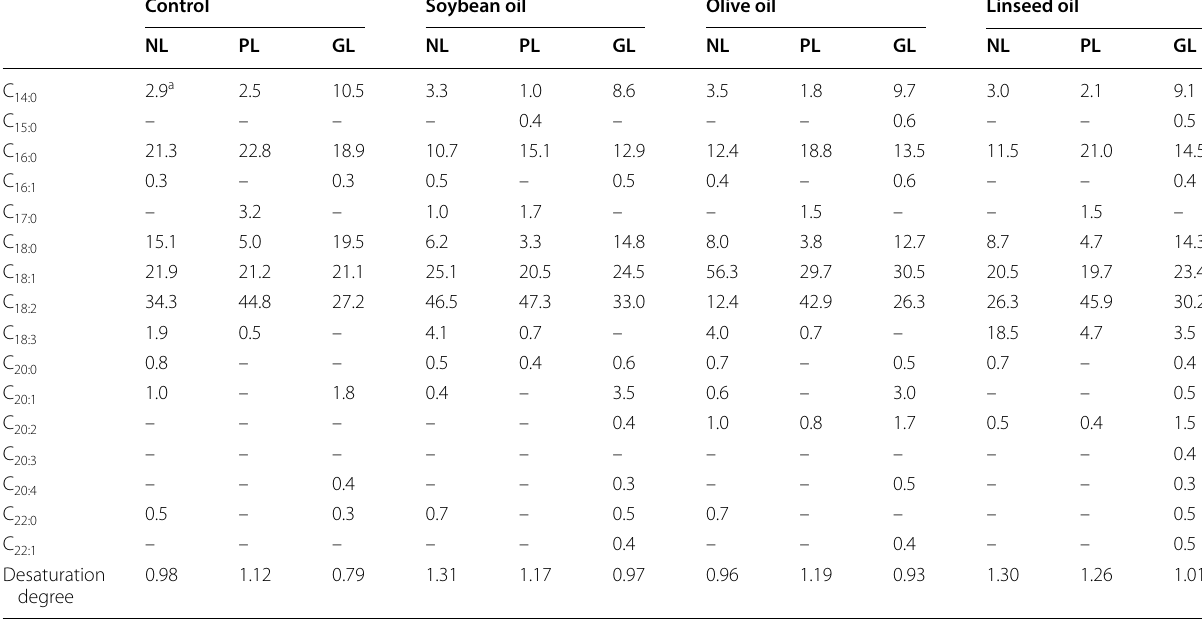
a All value mean the relative content of fatty acids, % of lipid